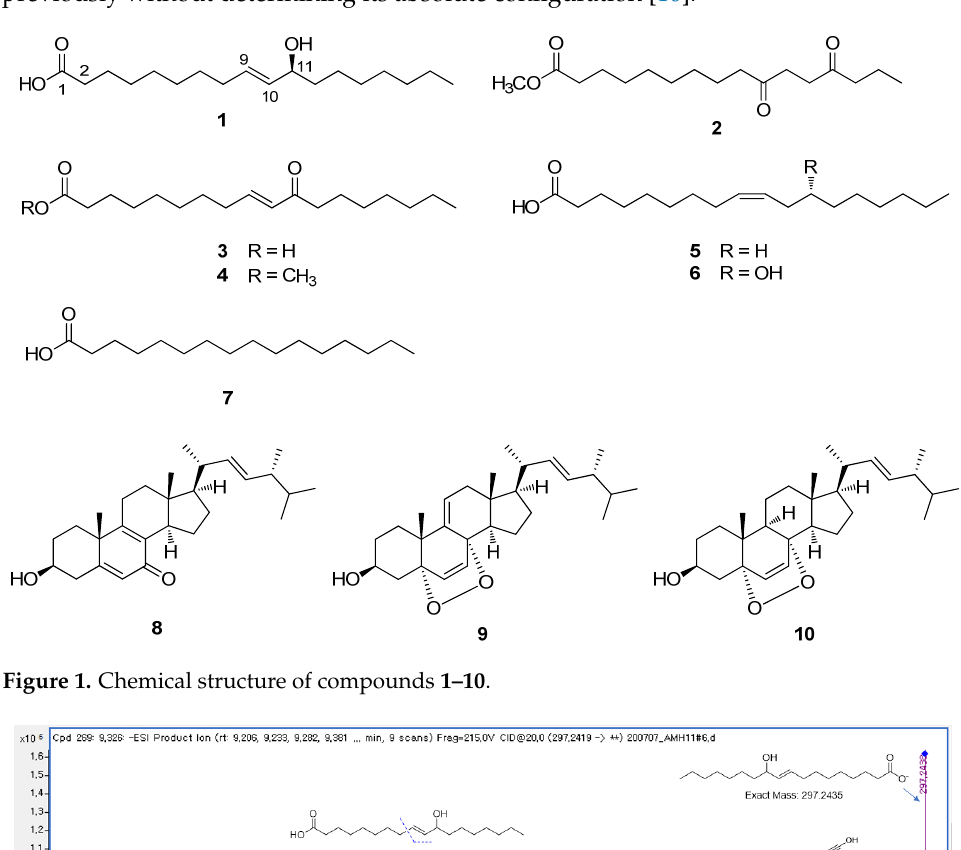
Figure 1. Chemical structure of compounds 1–10 .